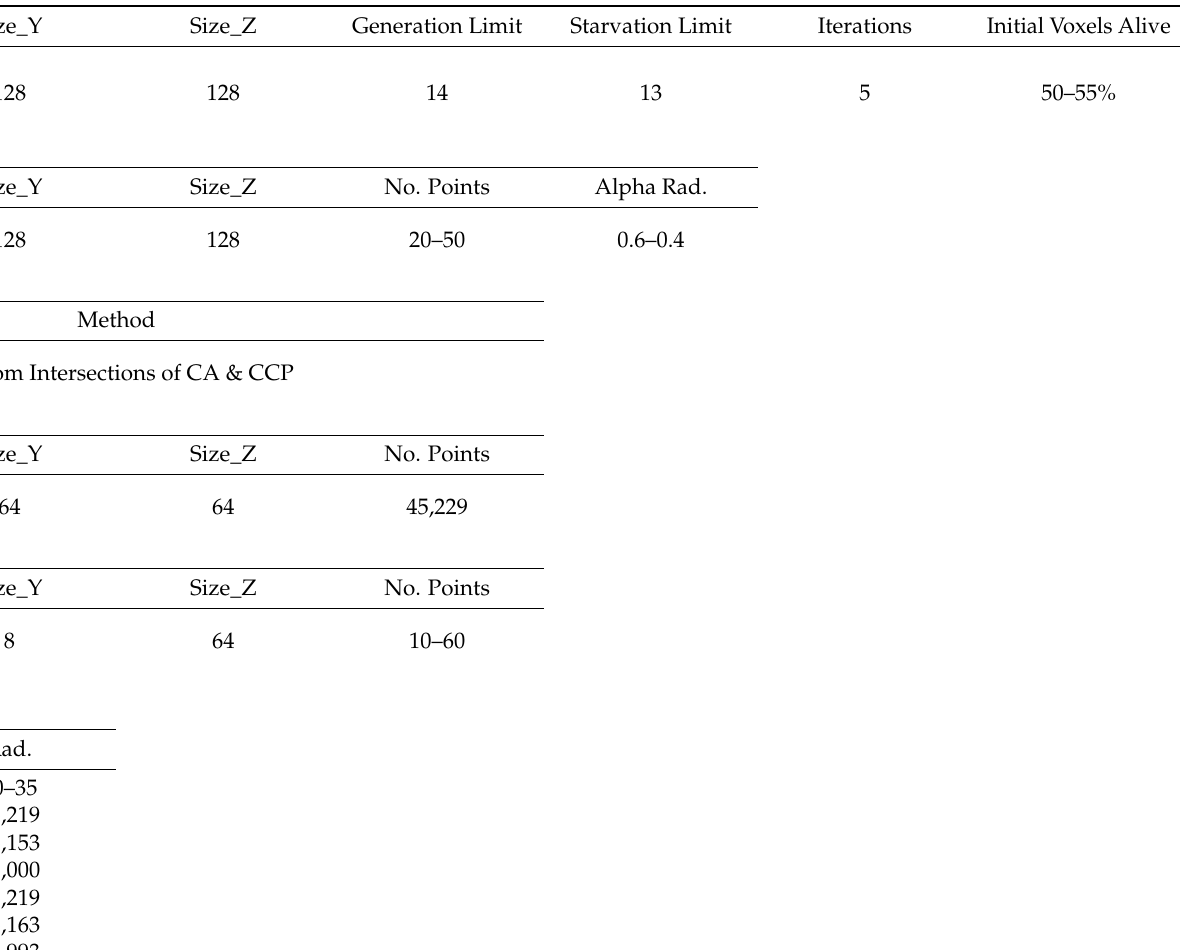
Table A3. Particles and fibers repositories